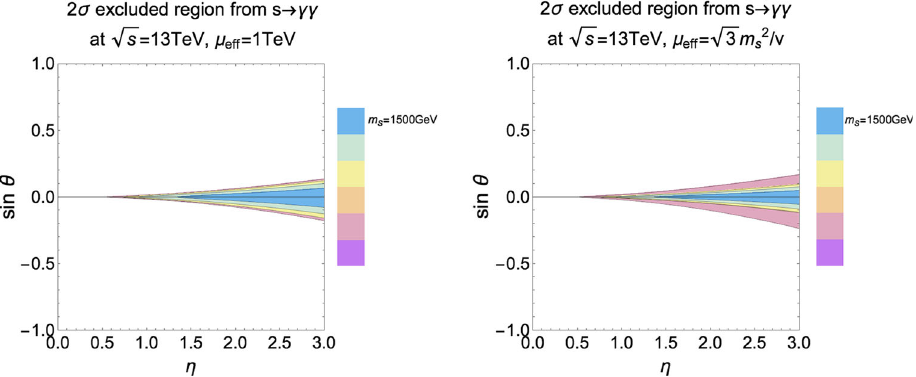
√ 3 m 2 s /v . The color is changed